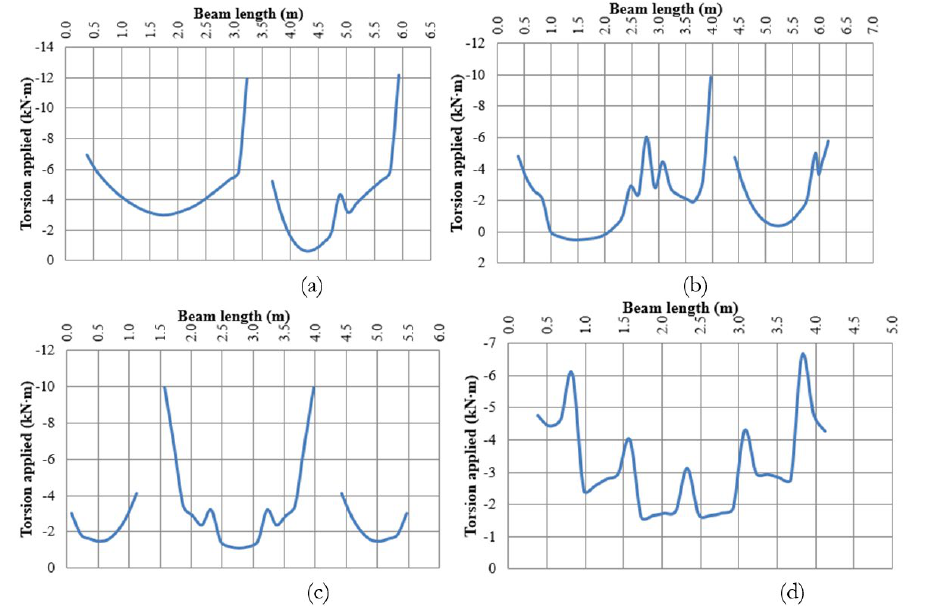
Figure 16. Torsion applied to reinforced concrete support beams without considering wind action: (a) Wall 1; (b) Wall 30; (c) Wall 3; (d) Wall 41.